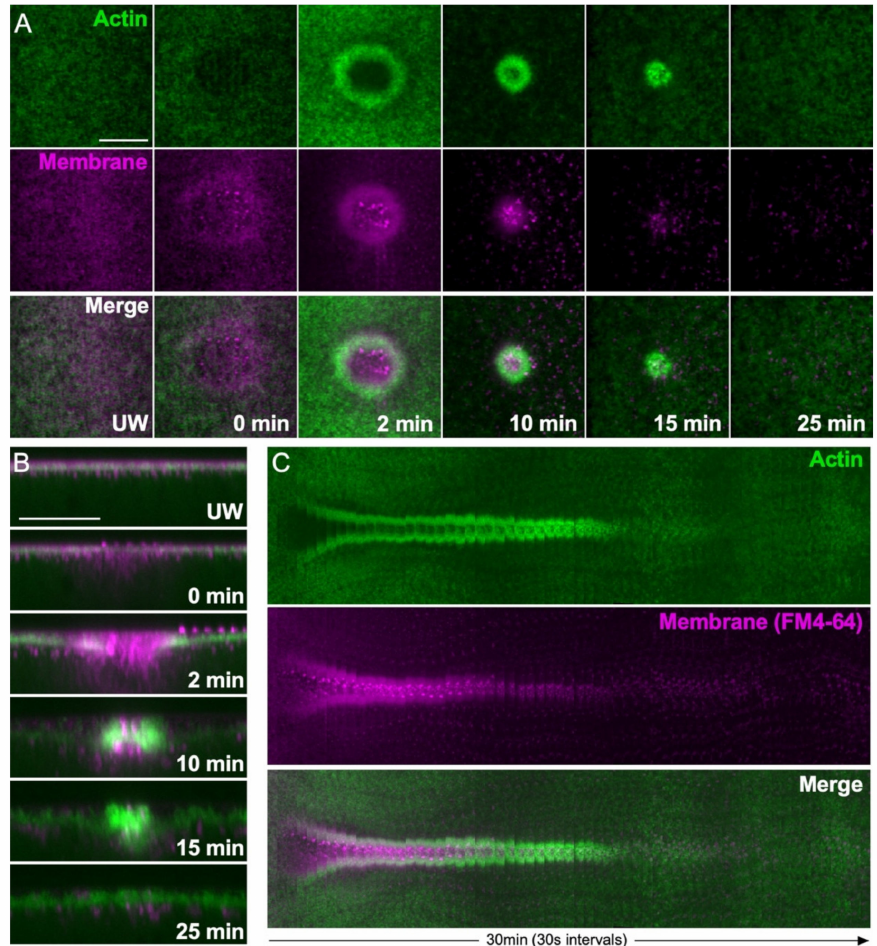
Figure 2. Actin ring and membrane dynamics during cell wound repair in the Drosophila model. ( A ) XY projection confocal micrographs of a syncytial Drosophila embryo expressing an actin reporter (green) and injected with a membrane dye (FM4-64, magenta) during the wound repair process. Scale bar: 20 µ m. ( B ) Confocal micrographs of cross-sections from the images depicted in ( A ). Scale bar: 20 µ m. ( C ) XY kymograph across the wound area depicted in ( A ). During the wound repair process, a temporary membrane patch reseals the hole, then an actin ring at the wound periphery pulls the plasma membrane closed. The temporary membrane patch is eventually removed from the wound site by internalization and extracellular